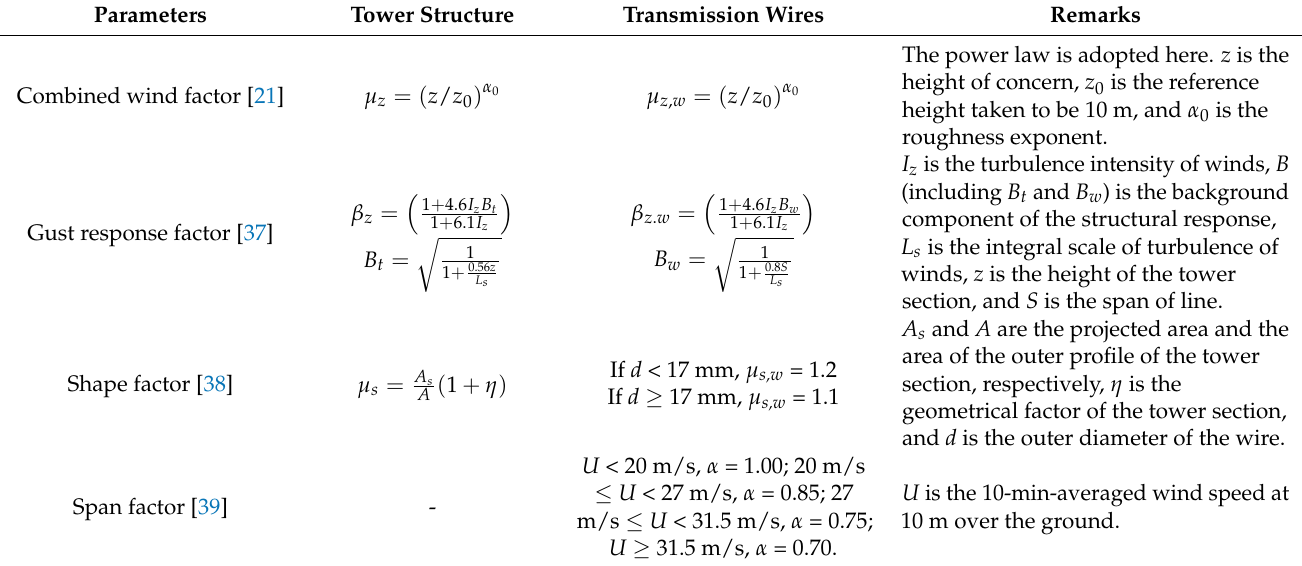
Table A1. Wind-structure interaction parameters.